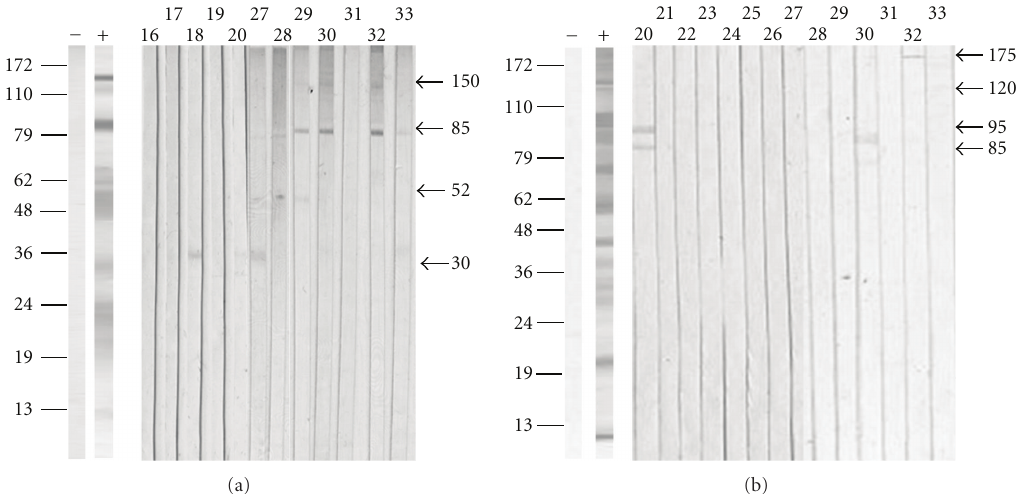
Figure 4: (a) Western blot with Taenia solium cysticerci E/S Ag was tested with 33 hamster sera infected with T. solium tapeworms (1–33). Preimmune (lane − ) and hyperimmune hamster sera anti- T. solium cysticercus E/S Ag (lane +) was used as negative and positive controls. WB shows representative samples of the assay. Number of lanes is corresponding to serum number of the assay. (b) Western blot with Taenia solium cysticercus CE was tested with 33 hamster sera infected with T. solium tapeworms (1–33). Preimmune (lane − ) and hyperimmune hamster sera anticysticerci CE (lane +) were used as negative and positive controls. WB shows representative samples of the assay. Number of lanes is corresponding to serum number of the assay.